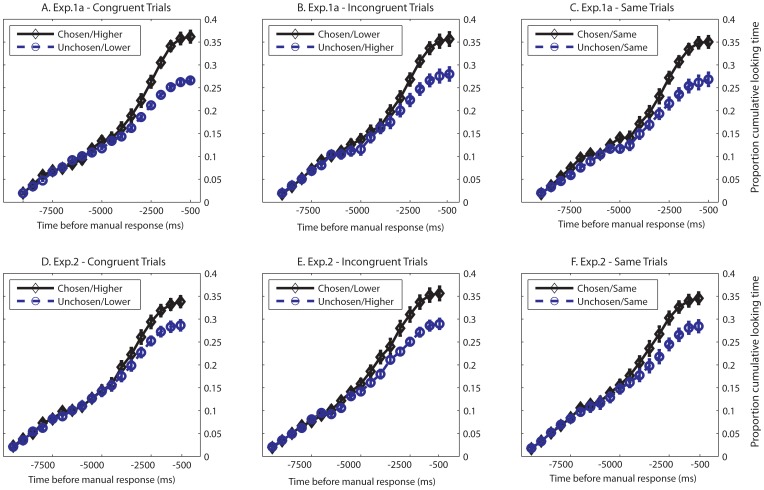
Proportional cumulative fixation durations time-locked to the manual response indicating choice decision.Trials were analyzed separately based on the congruency between choice and baseline aesthetic ratings. Figures 4A and 4D contain congruent trials (chosen item also had higher baseline rating), for Experiments 1a and 2, respectively. Figures 4B and 4E contain incongruent trials (chosen item had lower baseline rating). Figures 4C and 4F contain trials with objects given the same baseline rating. Looking times diverged statistically substantially earlier than the explicit manual response (3500ms before the aesthetic decision, and 2500ms before the organic decision).